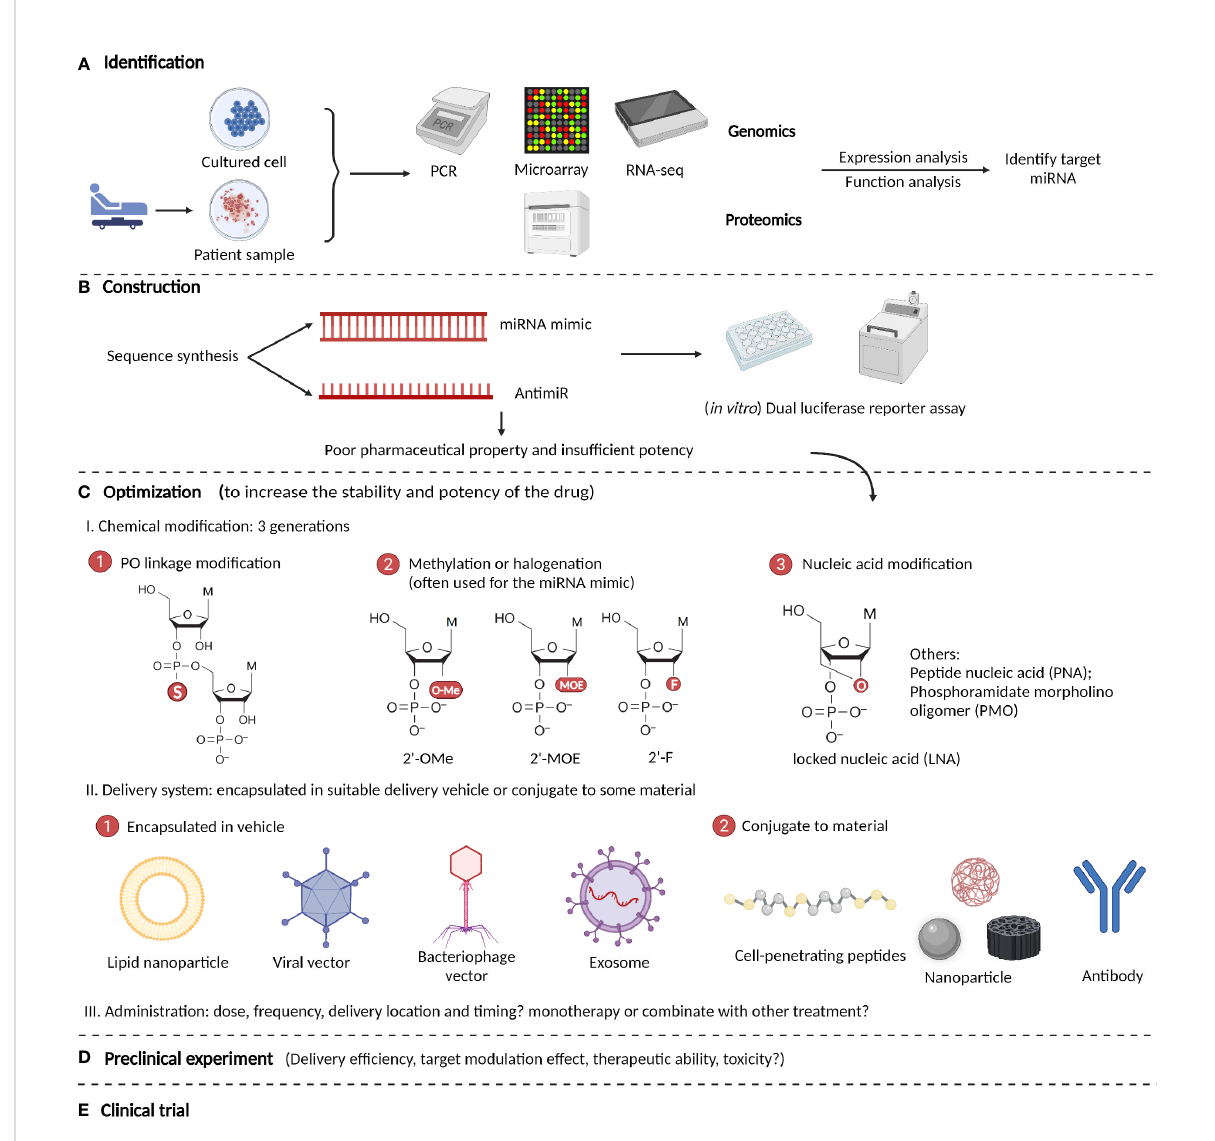
FIGURE 3 Procedures to develop microRNA-based therapeutics for ICH. (A) Identify target miRNA by genomic or proteomic expressional and functional analyses. (B) Construction of miRNA-based drugs (most are miRNA mimics and antimiRs) and performance of preliminary in vitro veri fi cation experiment such as dual luciferase reporter assays. (C) Optimization of the drug ’ s pharmacological properties via chemical modi fi cations and optimizing the delivery systems and administration patterns. (D) Rigorous preclinical experiments are performed to test the drug ’ s potency and ef fi ciency in ICH. (E) Clinical trials are performed to examine the drug ’ s curative ef fi ciency, suitable administration patterns, and toxicity or side